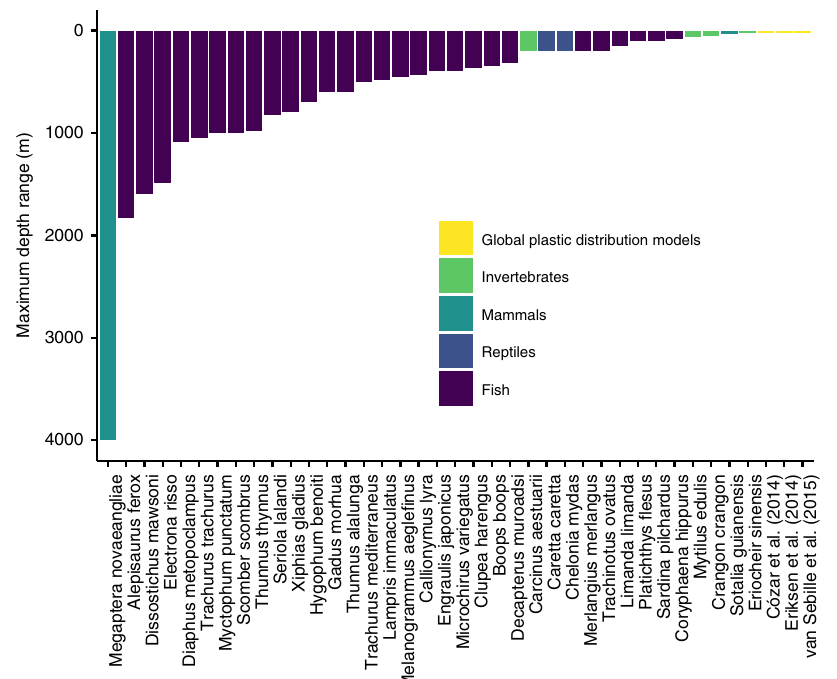
Fig. 2 Animal depth ranges in the water column exceed plastic pollution models. Water column depth range of species included in meta-analysis compared to depth range of established global plastic models. Cózar et al. 11 , Eriksen et al. 8 and van Sebille et al. 10 are well cited distribution models of buoyant plastics fl oating at the surface of the Earth ’ s oceans (674, 946 and 255 citations, respectively (Google Scholar 2019)). We assigned a crude water depth value of 25 m to each of these models, to account for the oceanic surface mixed layer, according to Kukulka et al. 31